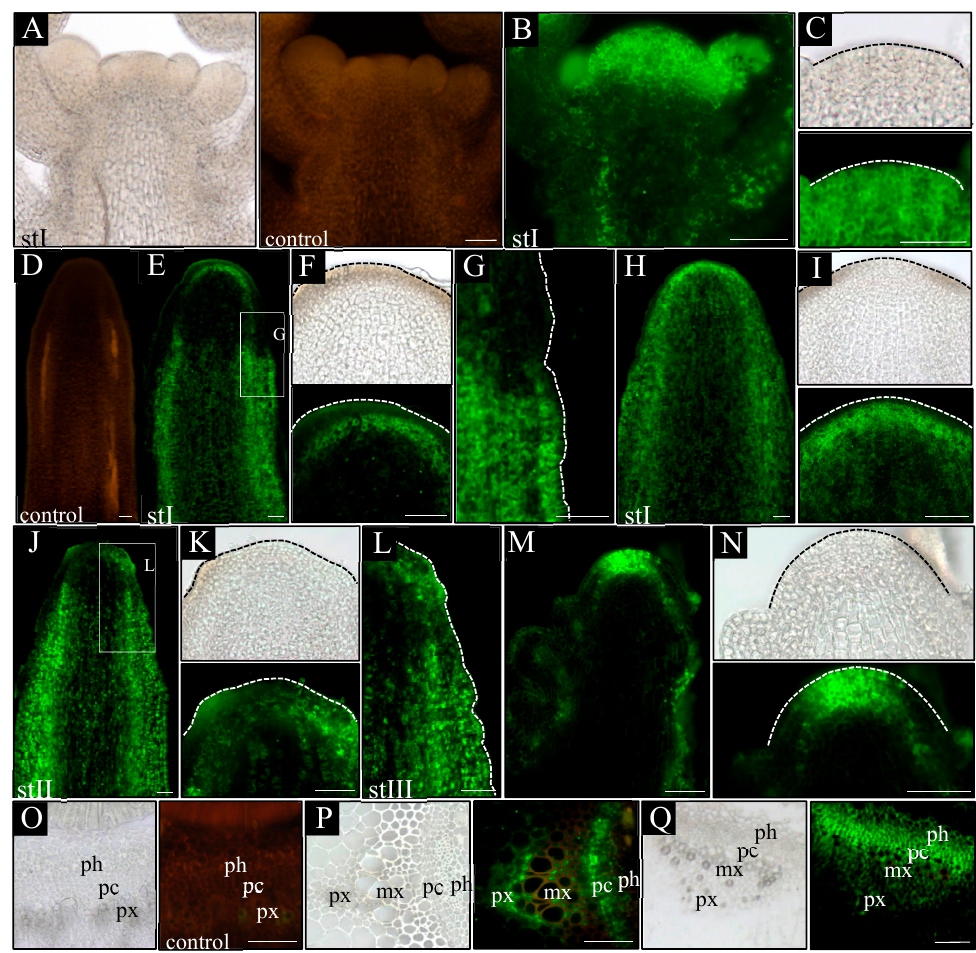
Figure 5. Immunolocalization of auxin in the inflorescence stems. Longitudinal ( A – N ) and transversal ( O – Q ) sections through the apical part of the inflorescence stems of WT ( A – C , O – P ) and pin1 mutant ( D – N , Q ) plants. On the longitudinal sections, in WT plants, the strongest signal of auxin immunolocalization is visible in the entire meristem, developing organs and all vascular strands ( B , C ). In the pin1 mutant, in stage I, the auxin signal is visible in the L3 layer of the meristem, vascular strands of the apical part of stem ( E , F ) and in all cell types of the more basal stem region ( G ), or in all cells of the entire shoot, except the surface layers ( H , I ); in stage II, the auxin immunolocalization signal is additionally visible in the L1 layer of the peripheral zone ( J , K ), and the more basal region, characterized by the presence of the auxin signal in all cells, is closer to the meristem ( L ); in stage III, the immunolocalization signal is visible in the L1–L3 layers of the entire meristem, the surface layer of the organs and all vascular strands ( M , N ). On the transversal sections, in WT plants, auxin immunolocalization signal accumulates in the procambial region, phloem and all cells of xylem parenchyma ( P ). In the pin1 mutant, the signal is visible in the procambial region, phloem, and xylem parenchymal cells on the protoxylem side ( Q ). ( A , D , O ) Tissue autofluorescence (control); ( C , F , I , K , N ) magnifications of the meristems, meristem outlined with dashed line; ( G , L ) magnifications of the marked regions, the surface of stem outlined with dashed line. St I–III—successive developmental stages; px—protoxylem; mx—metaxylem; ph—phloem; pc—procambium. Scale bar 50 µ